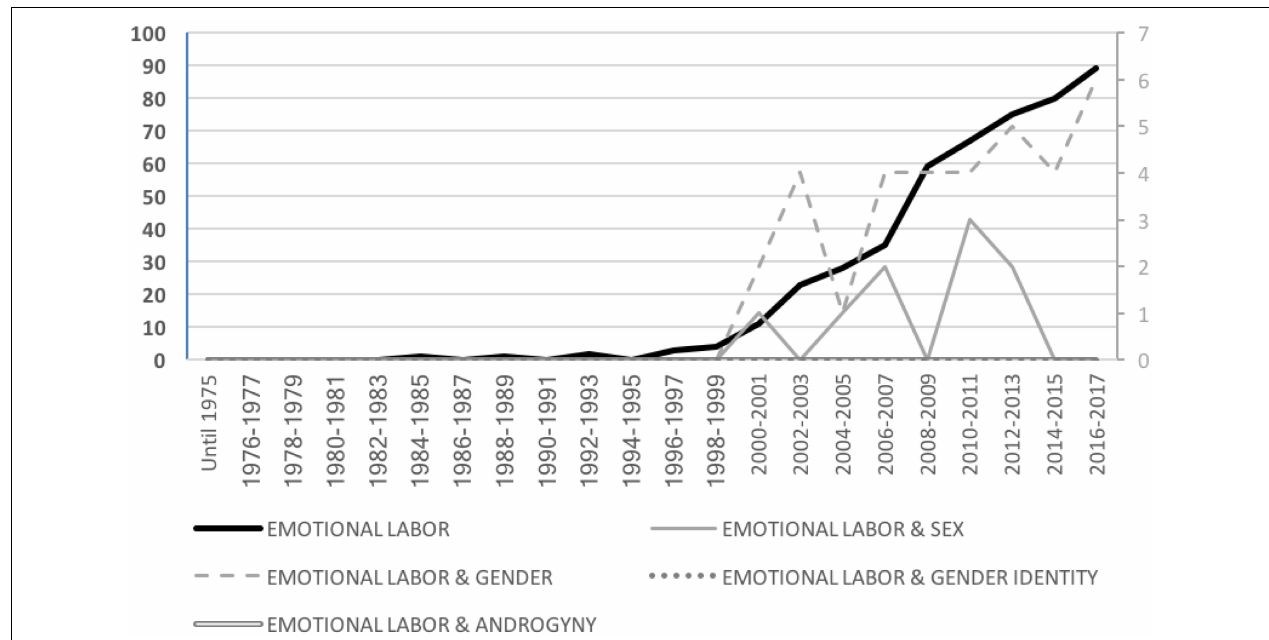
FIGURE 5 | Total number of scientific articles per year about emotional labor by gender category.